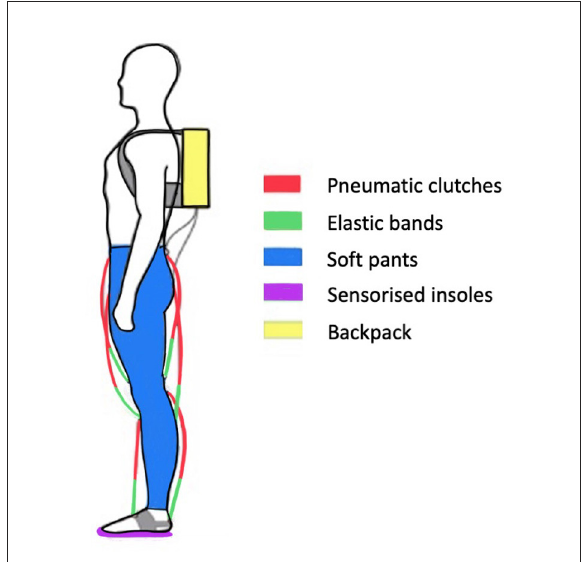
FIGURE5 Structure of the XoSoft-Gamma exoskeleton. The exosuit consists of pneumatic clutches connected in series with elastic bands, soft pants, sensorized insoles, and a backpack containing electronic and pneumatic